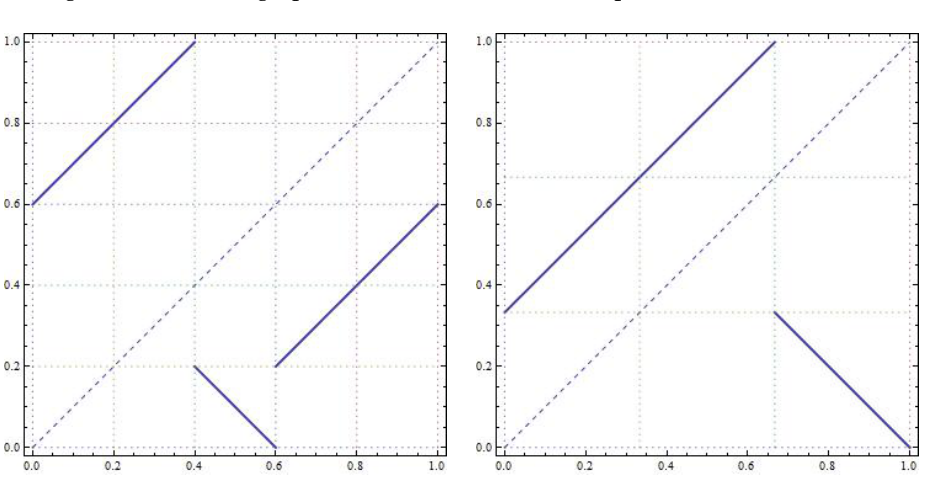
Figure 7. The graph of IET T a with permutation ( 3, − 1,2 ) and a = 0.4 ( left ). On the ( right ), the graph of its Poincaré